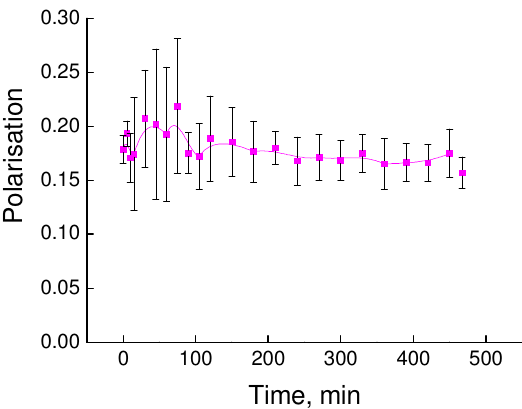
Figure 6. The dependence of the fluorescence polarization degree of the dendriplex formed by fluorescein-labeled siP24 and P4 on the time of